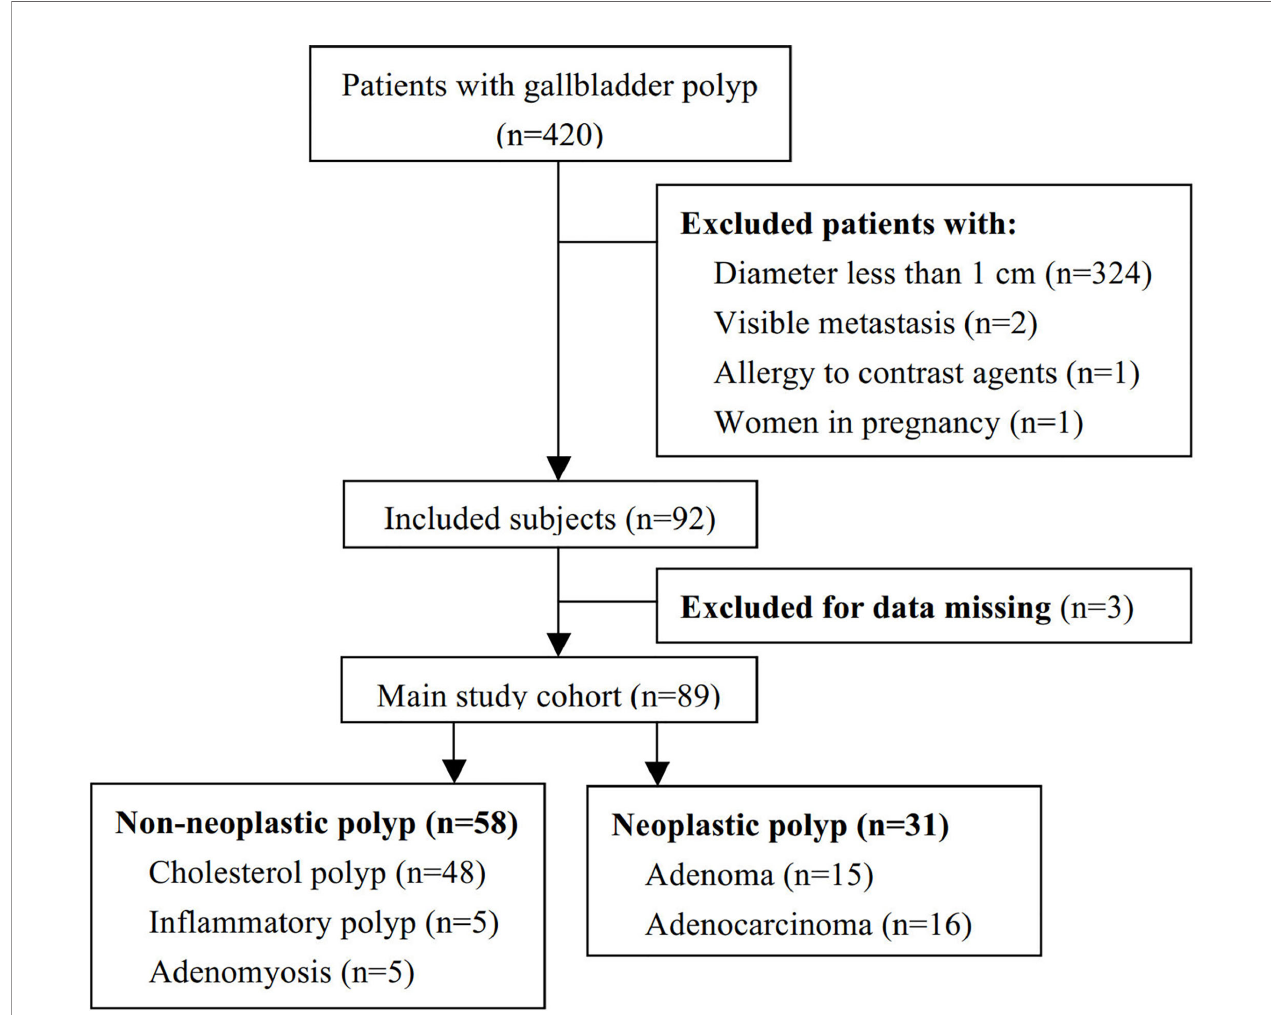
FIGURE 1 | Flow chart of the patient inclusion